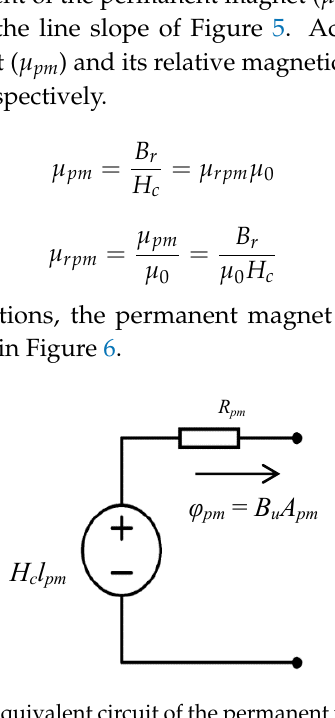
Figure 6. The magnetic Thévenin equivalent circuit of the permanent magnet in terms of its parameters.